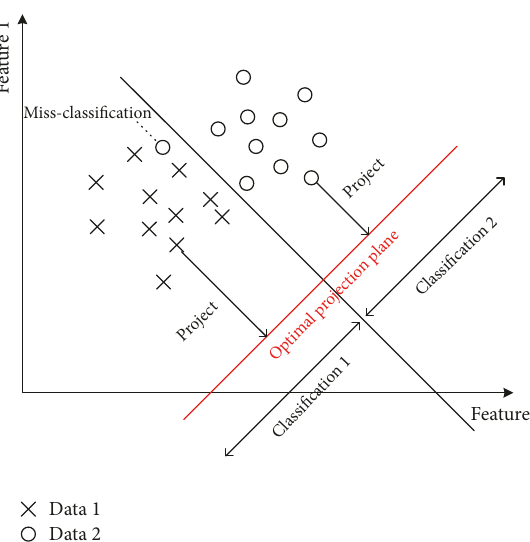
Figure 5: Schematic diagram of Fisher discriminant